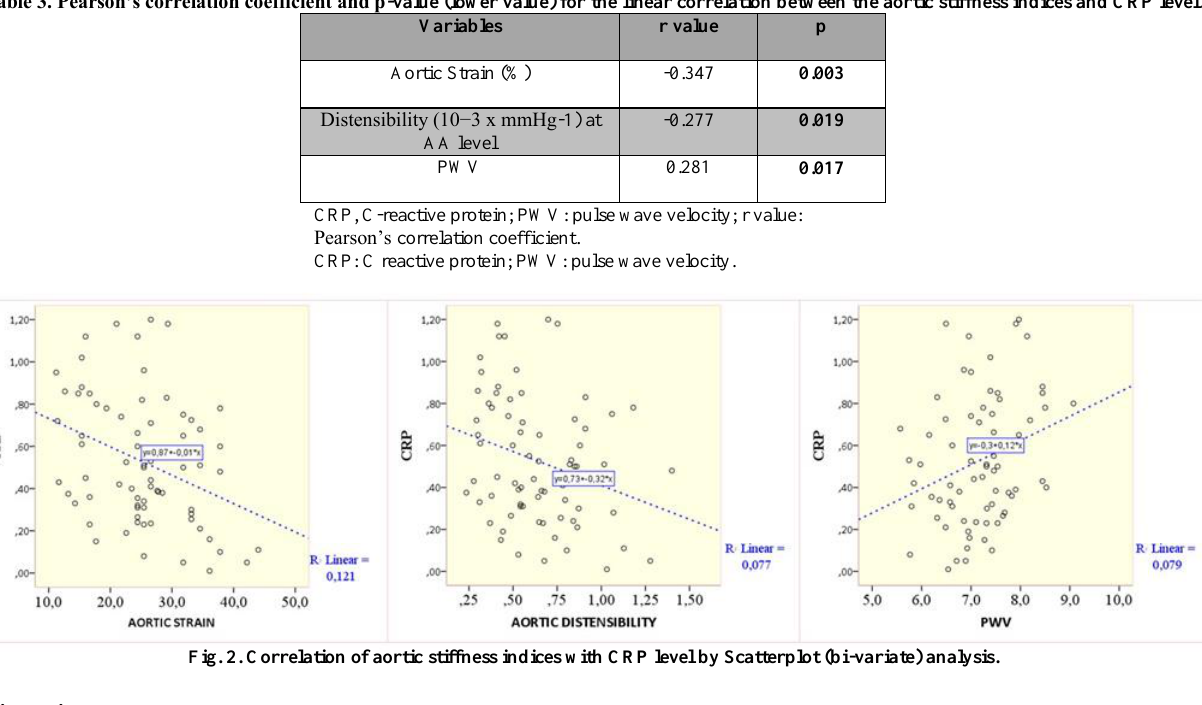
Table 3. Pearson’s correlation coefficient and p-value (lower value) for the linear correlation between the aortic stiffness indices and CRP level. Variables